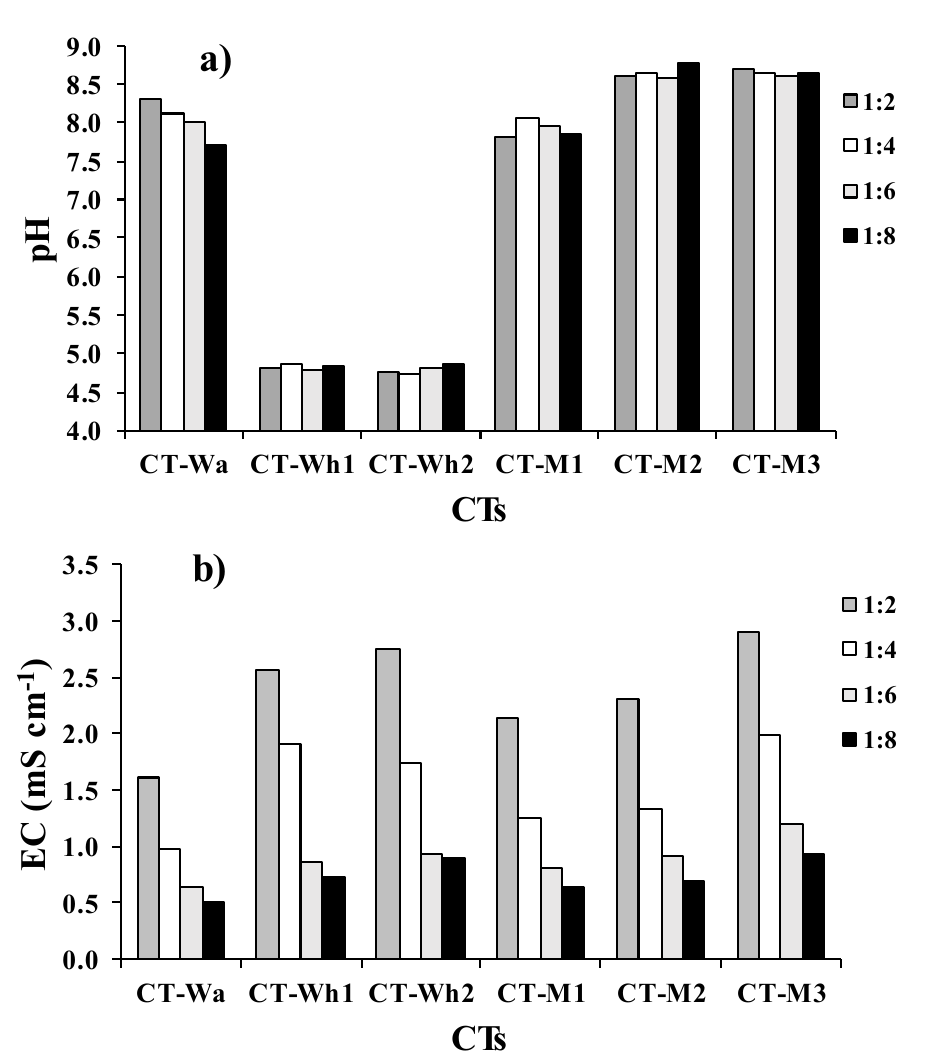
Figure 2. pH values ( a ) and electrical conductivity (EC) ( b ) measured in CTs diluted with tap water at different ratios (1:2; 1:4; 1:6; 1:8).